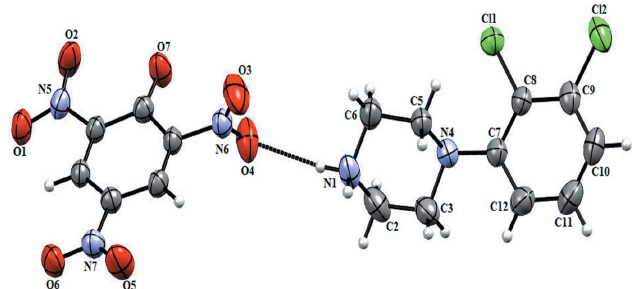
Figure 1 The title compound shown with 50% probability ellipsoids. The hydrogen bond is shown as a dashed line.